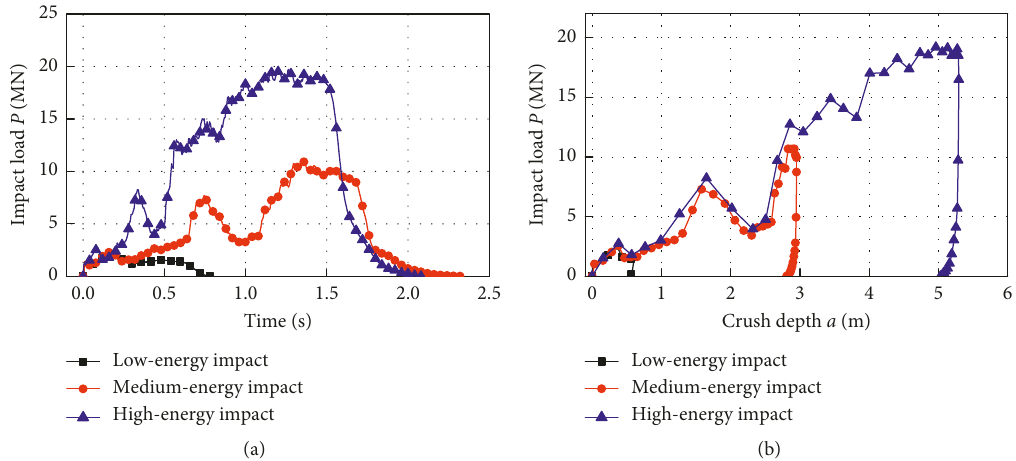
Figure 6: Impact load comparisons between the low- and high-energy impact. (a) Impact load time history. (b) Impact load versus crush depth.